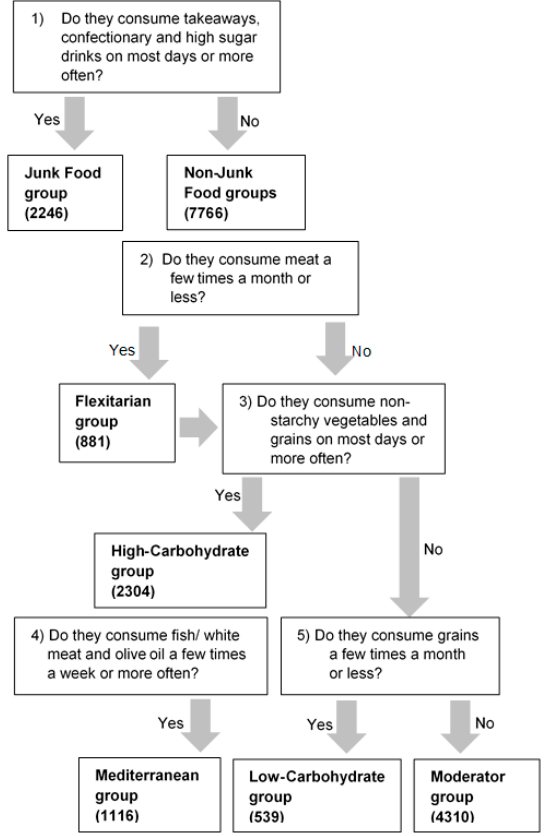
Figure 1. Questions from the Sovereign Wellbeing Index (2014) used to develop six novel nutrition profiles 1 . 1 Numbers in brackets are the nutrition profile group size ( n ).